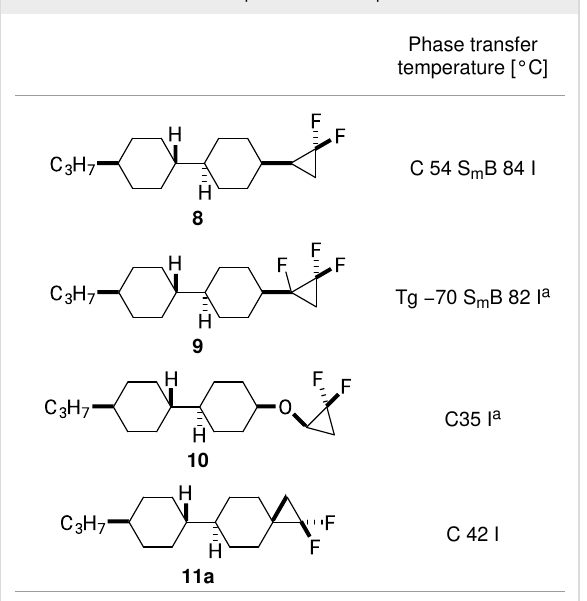
Table 1: Phase transition temperatures of compounds 8 – 11 .